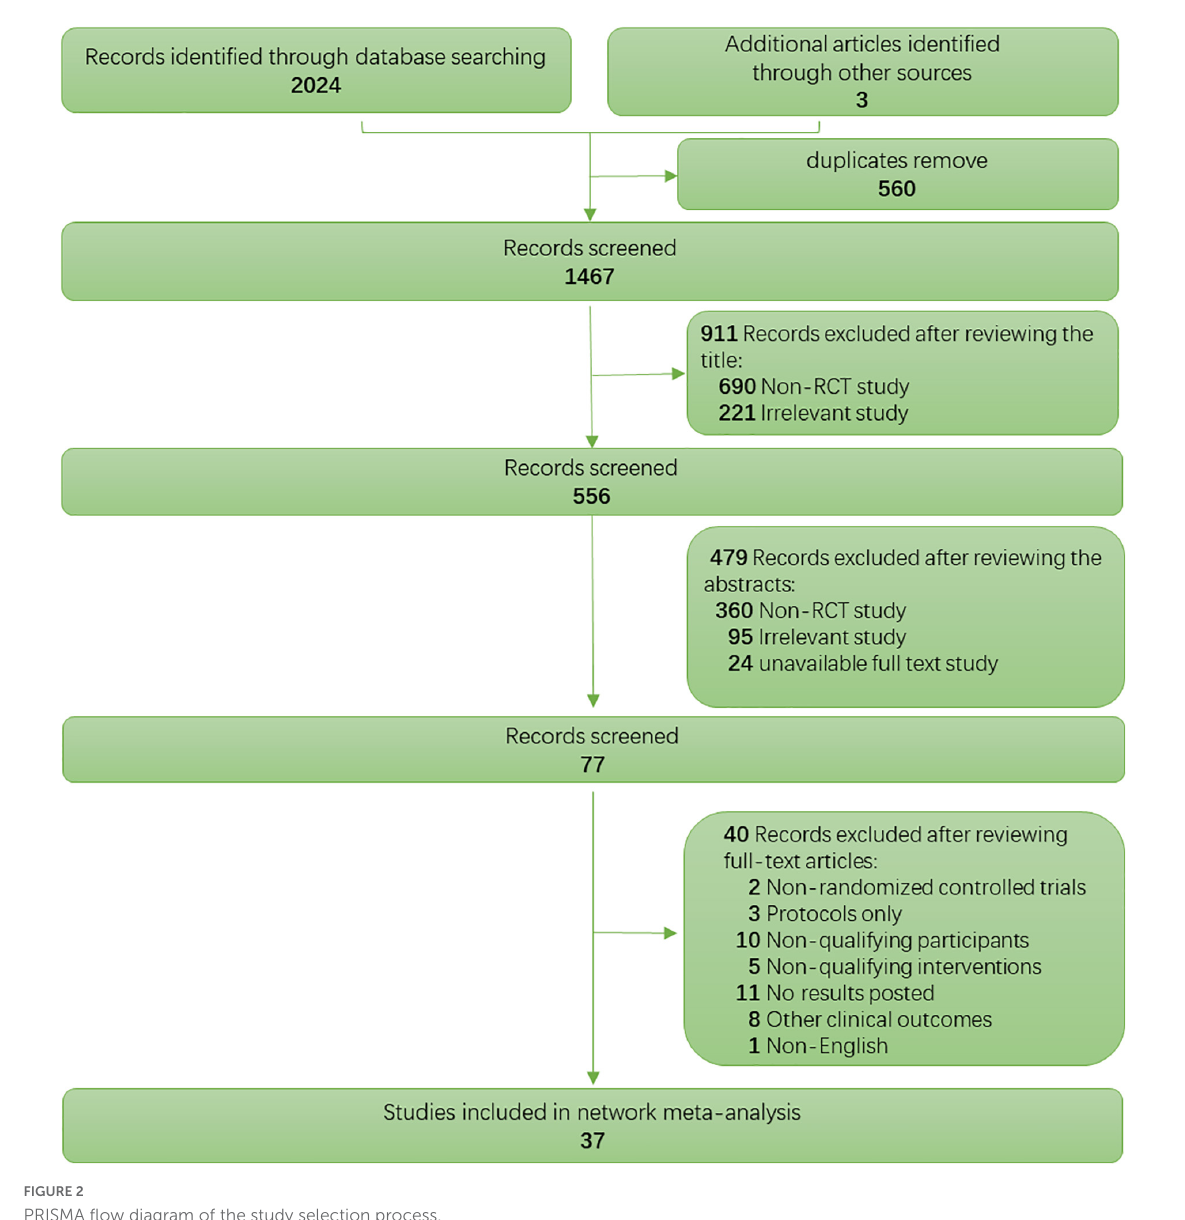
FIGURE2 PRISMA flow diagram of the study selection process.